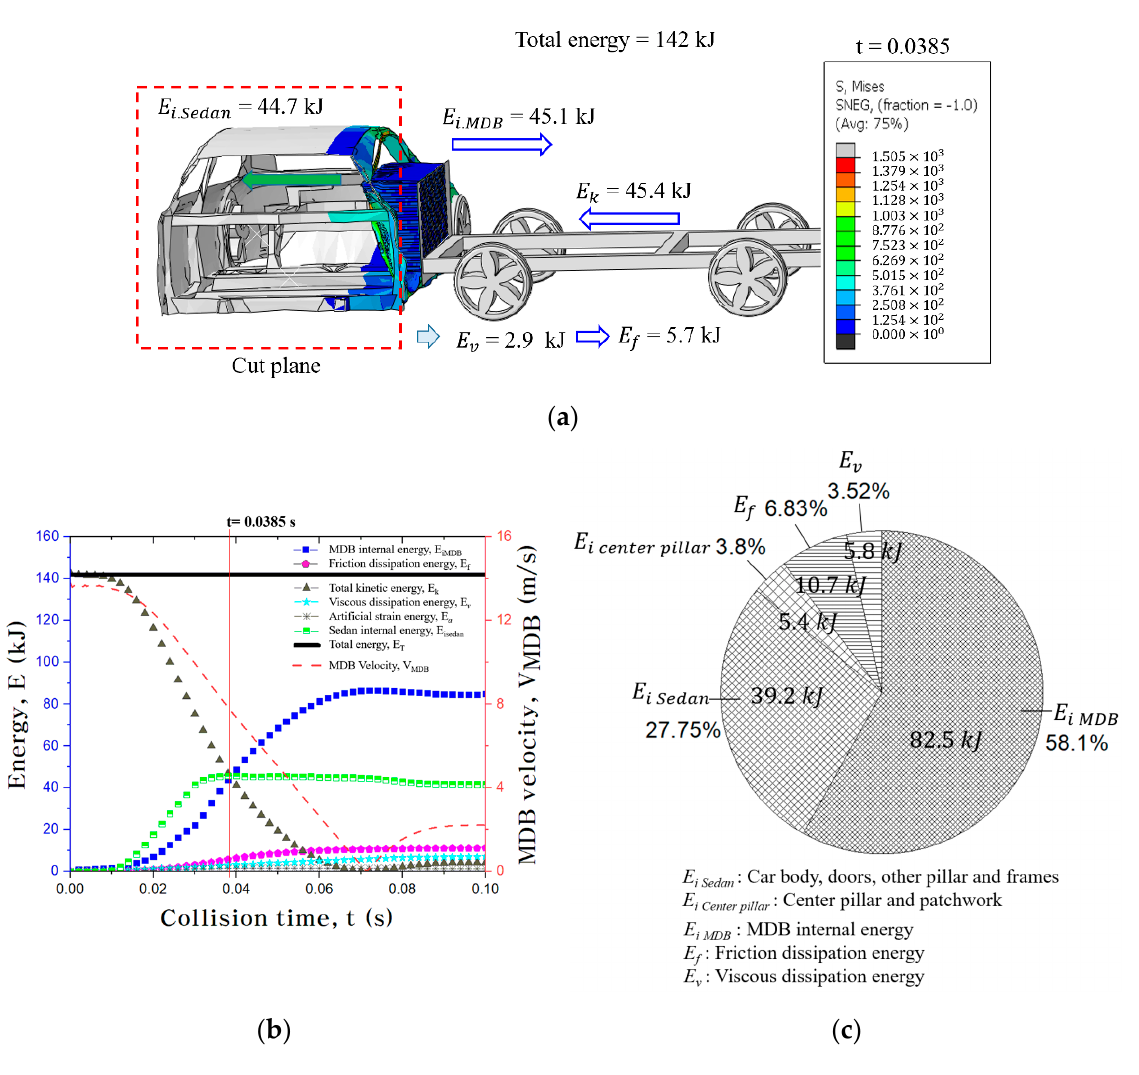
Figure 11. Energy conversion during side crash: ( a ) flow of energy distribution at t = 0.0385 s; ( b ) distribution of energies according to collision time; ( c ) distribution of energy conversion at t = 0.071 s.